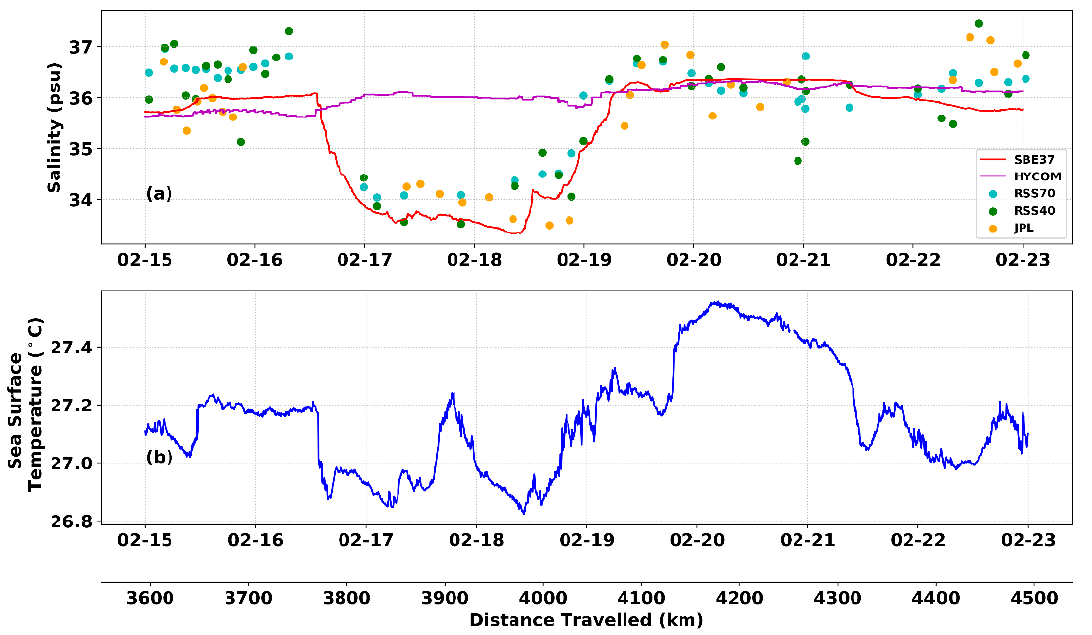
Figure 7. Time series of ( a ) the salinity measured by the SBE37 sensor onboard the saildrone 1026 compared with that of HYCOM, RSS70, RSS40 and JPL satellite salinity products and ( b ) the sea surface temperature measured while saildrone 1026 crossed the fresh tongue southeast of Barbados